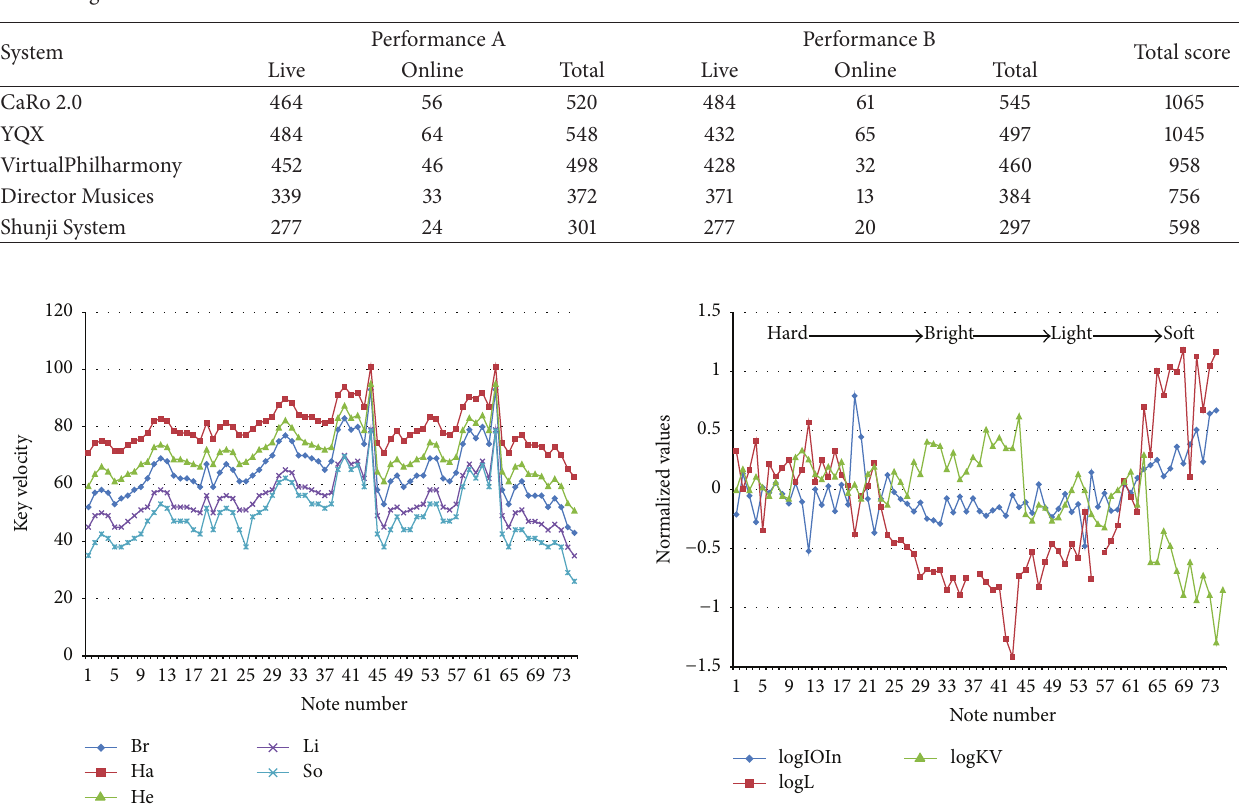
Table 3: Results of the final stage of the Rencon 2011 contest. Each system was required to render two different performances of the same music piece. Each performance has been evaluated both by the audience attending the contest live and by people connected online through a streaming service.